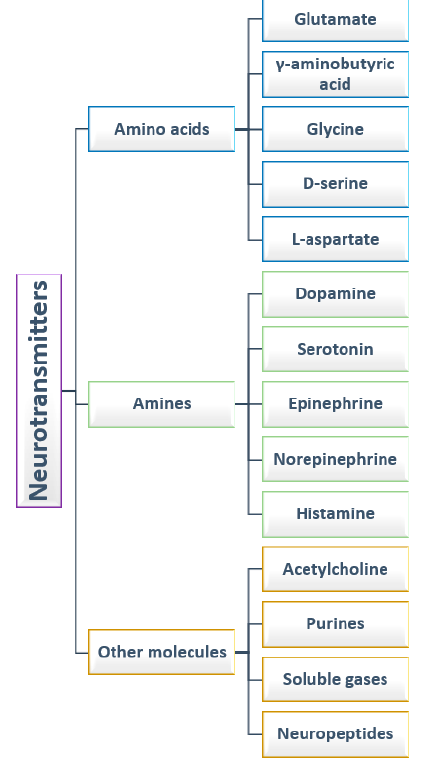
Figure 1. Classification of neurotransmitters.